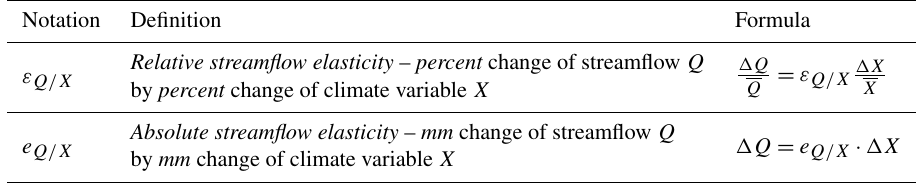
Table 1. Summary of the elasticity notations used in this paper ( X being precipitation P or potential evaporation E P ).